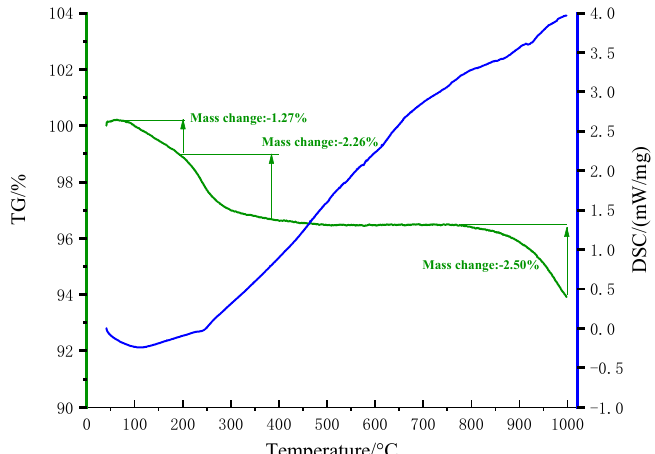
Figure 2. TG-DSC of the raw material.